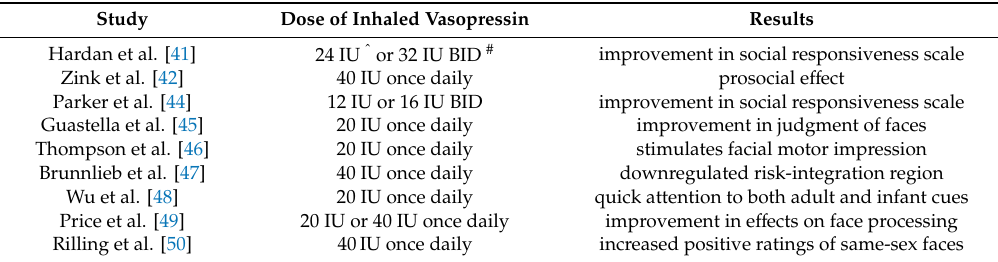
Table 1. List of studies in which inhaled vasopressin was